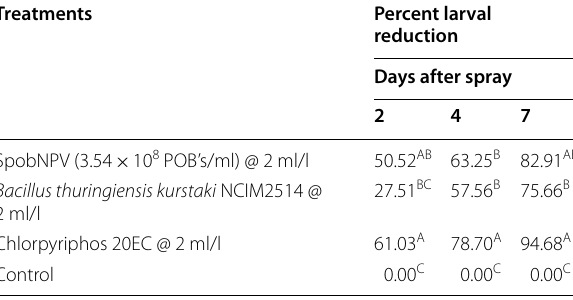
Table 3 Percent larval reduction by Spilosoma obliqua Nucleopolyhedrosis virus ( Spob NPV) against third instar larvae of Spilosoma obliqua (pooled mean data for the years 2020 and